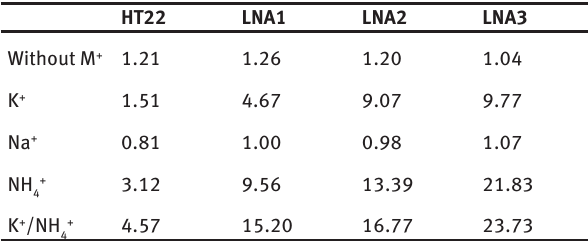
Table 5: Comparison of relative activities (V LNA-modified DNAzymes. HT22 LNA1 LNA2 LNA3 Without M +